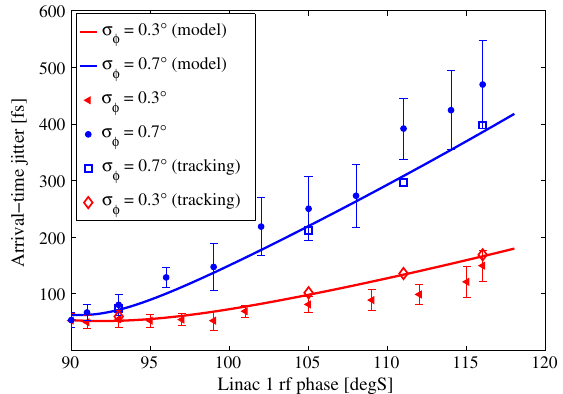
FIG. 10. Measurements, theoretical and numerical expectation of the ATJ versus linac phase for a rms rf phase jitter of 0.3 (cid:4) and 0.7 (cid:4) . R 56 ¼ (cid:3) 41 mm , (cid:1) t i from the injector is 60 fs (rms).